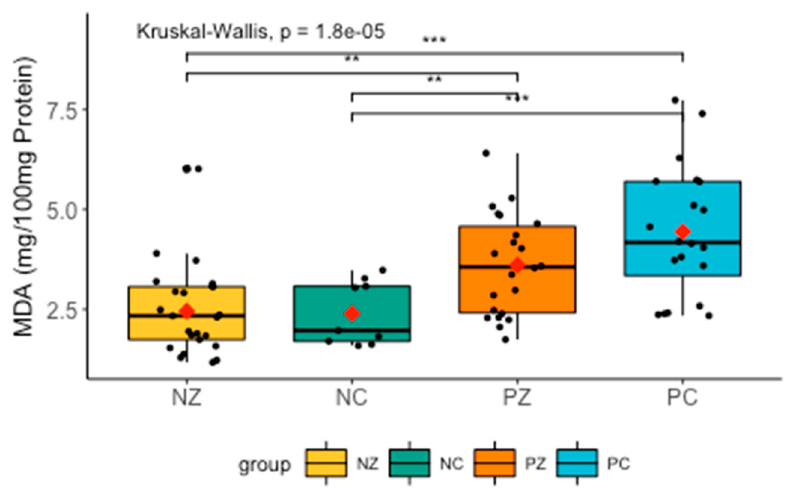
Figure 9. Levels of MDA in the saliva of the examined women. MDA, concentration of malondialdehyde; NZ, generally healthy patients without the BRCA1 mutation; NC, patients with breast cancer but without the BRCA1 mutation; PZ, generally healthy patients with the BRCA1 mutation; PC, patients with both breast cancer and the BRCA1 mutation. ** p < 0.01; *** p < 0.001.